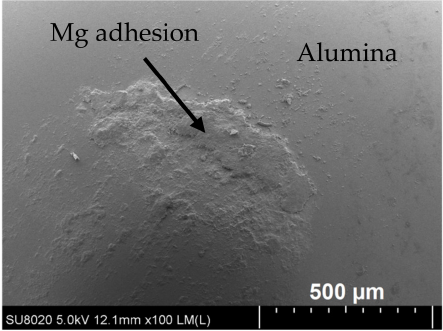
Figure 4. SEM picture of the alumina counter-body